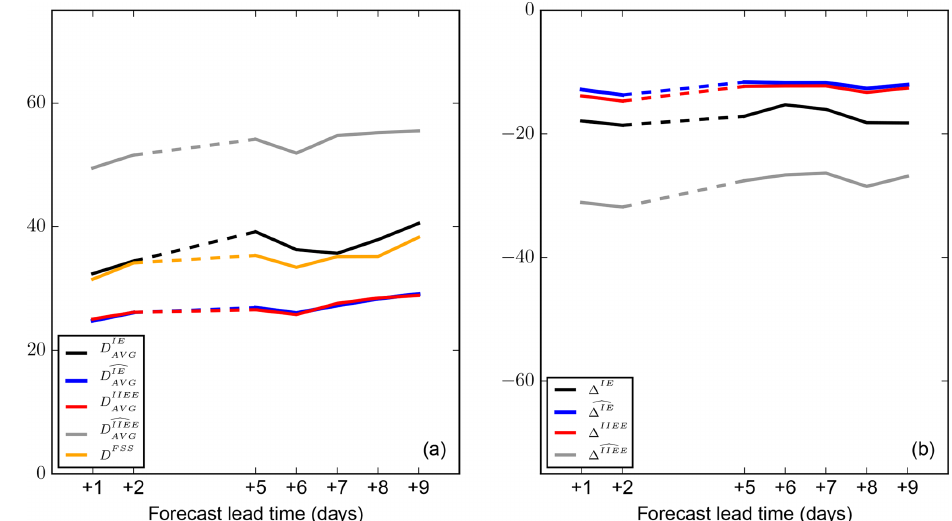
Figure 7. Metrics for (a) mean displacement and (b) bias as functions of forecast lead time in days. These results are based on forecast bulletins from January 2017 to mid-May 2017. Note that lines for (b) . Values along the vertical axes are in units of kilometres. Ice charts are not produced on Saturdays and Sundays, which correspond to forecast lead times of + 3 and + 4d, respectively. Dashed lines are thus used to indicate the lack of analysis for these two